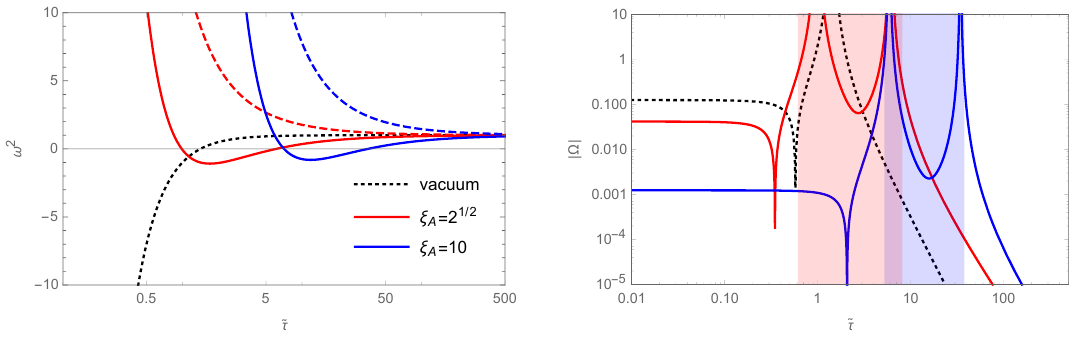
Figure 1 . E(cid:11)ective frequency squared ( ! 2 ) and deviation from adiabaticity ( j (cid:10) j ). The left panel shows ! 2 (3.2) as a function of ~ (cid:28) while the right panel shows j (cid:10) (cid:6) (~ (cid:28) ) j (3.6) for massless systems p ( (cid:11) H = 0) with (cid:24) A = 2 (red line) and 10 (blue line). For comparison, the dotted black line shows the vacuum gravitational waves. Here, the solid red and blue lines show the plus polarization modes while the dashed blue and red lines show the minus polarization. The shaded areas in the right panel show the particle production regime.